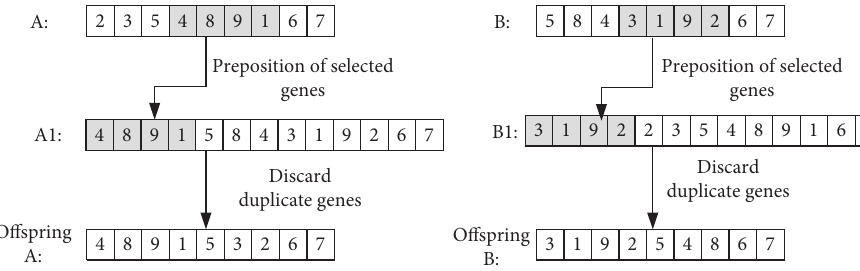
Figure 3: Partial matching crossover operation.